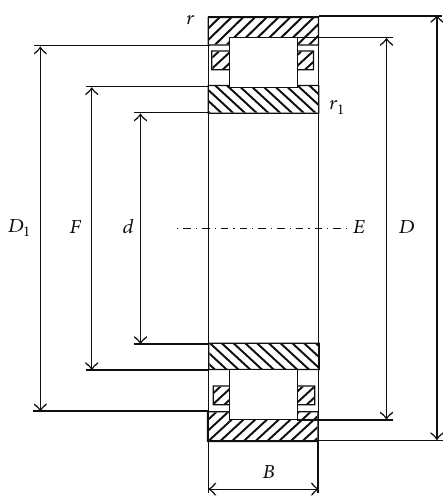
Figure 12: Profile of the rolling bearing.